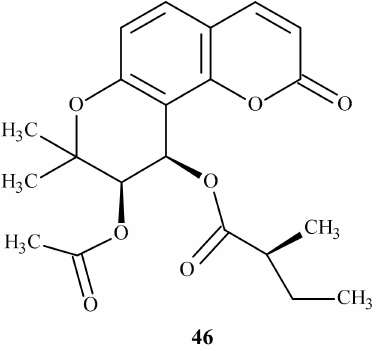
Figure 17. Structure of hyuganin C 46.